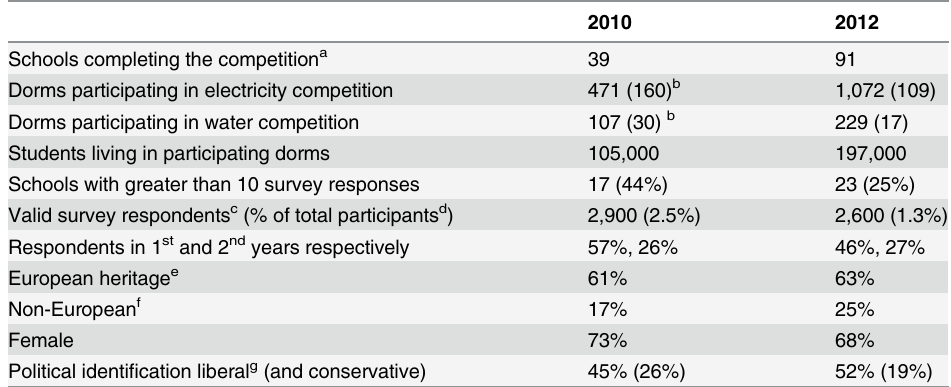
Table 1. Participation and demographics for 2010 and 2012